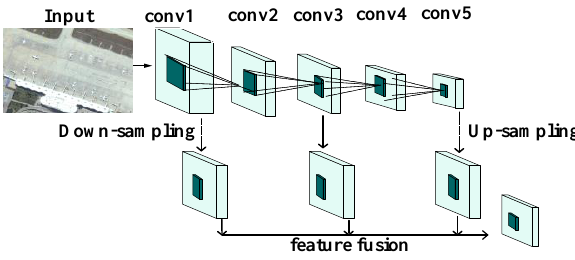
conv1 conv2 conv3 conv4 conv5